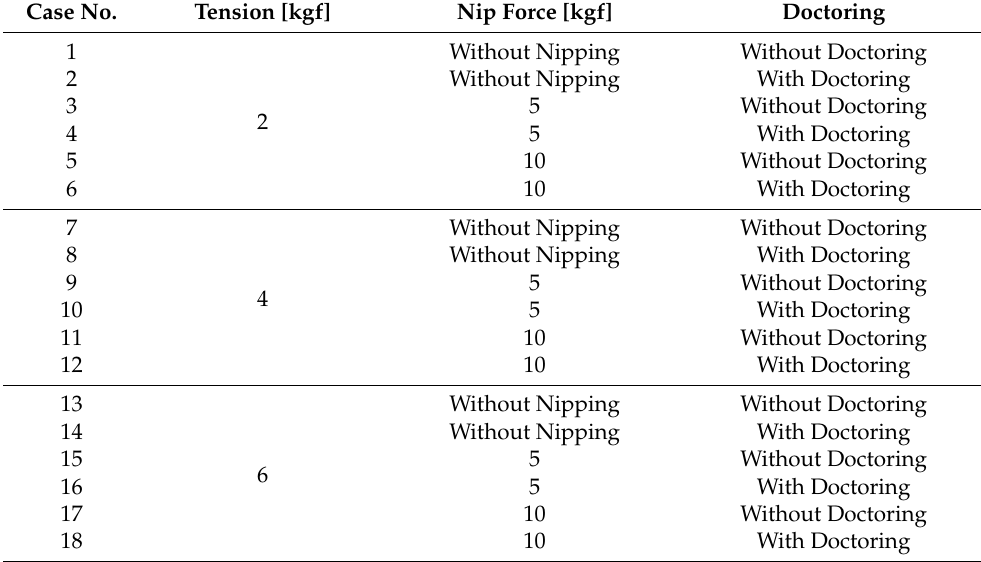
Figure 4. Possible main faults during gravure printing process: ( a ) Doctor blade tilting fault; ( b ) Printing roll eccentricity fault; ( c ) Nip roll eccentricity fault; and ( d ) Nip force non-uniformity fault. Table 2. Experimental design of data acquisition with experimental variables of tension, nip force, and